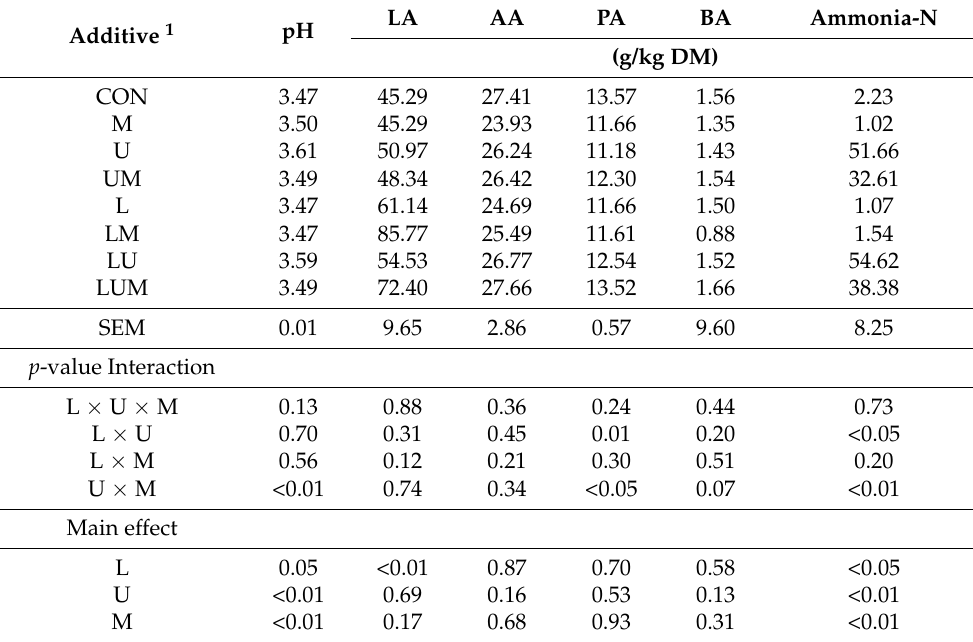
Table 3. Effect of cassava pulp by treated with Lactobacillus casei TH14, molasses, and urea on fermentation characteristics after fermentation.